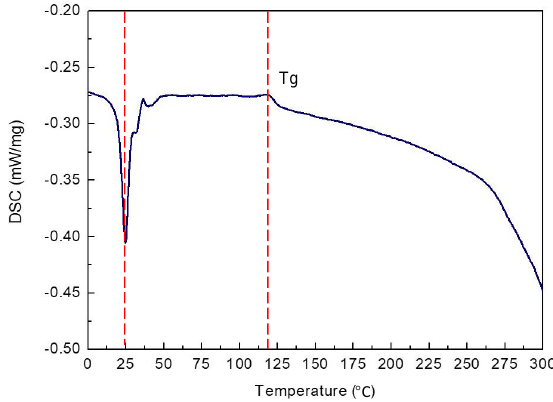
Figure 5. The differential scanning calorimetric (DSC) thermogram of the GFRPTFE.